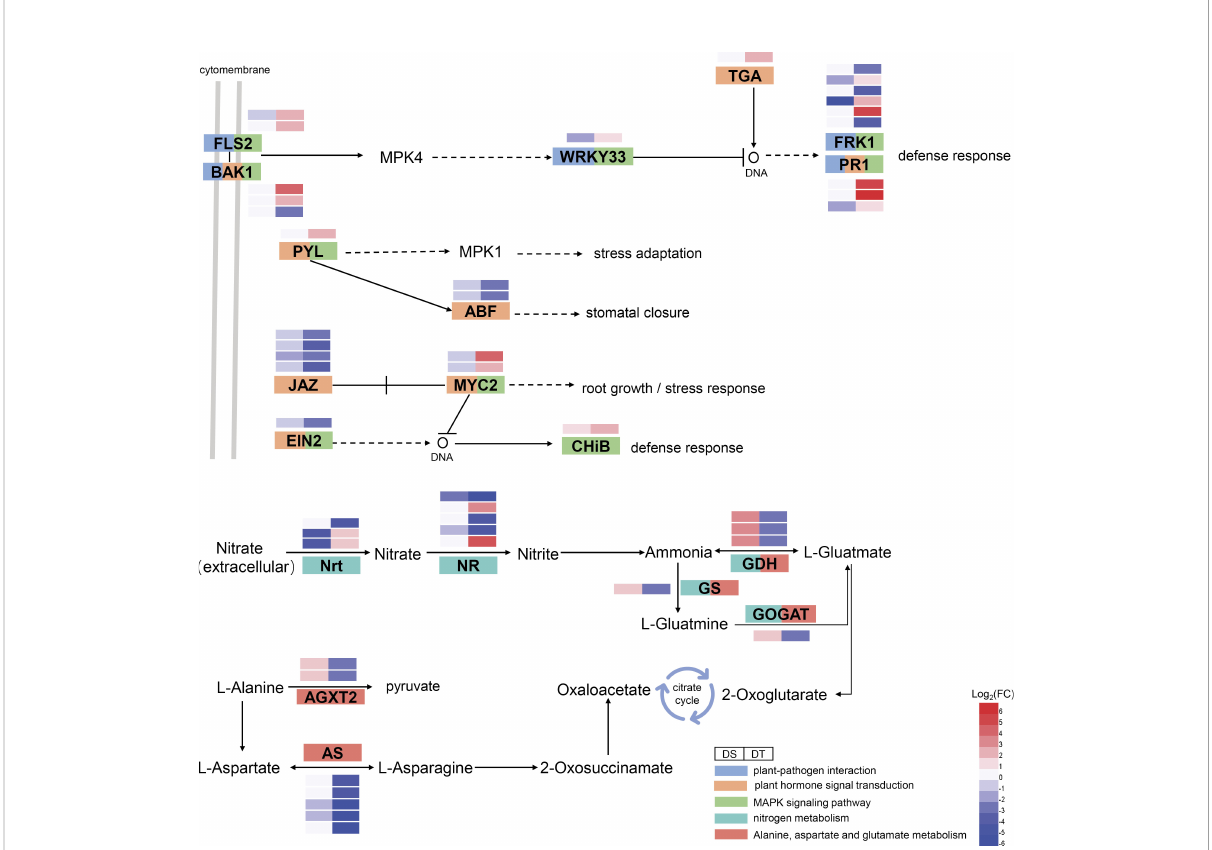
FIGURE 8 Expression patterns of DEGs in important pathways. Different colors represent different pathways. Genes containing more than two colors indicate their involvement in multiple pathways simultaneously. DS, drought-sensitive variety JM38, DT, drought-tolerant variety